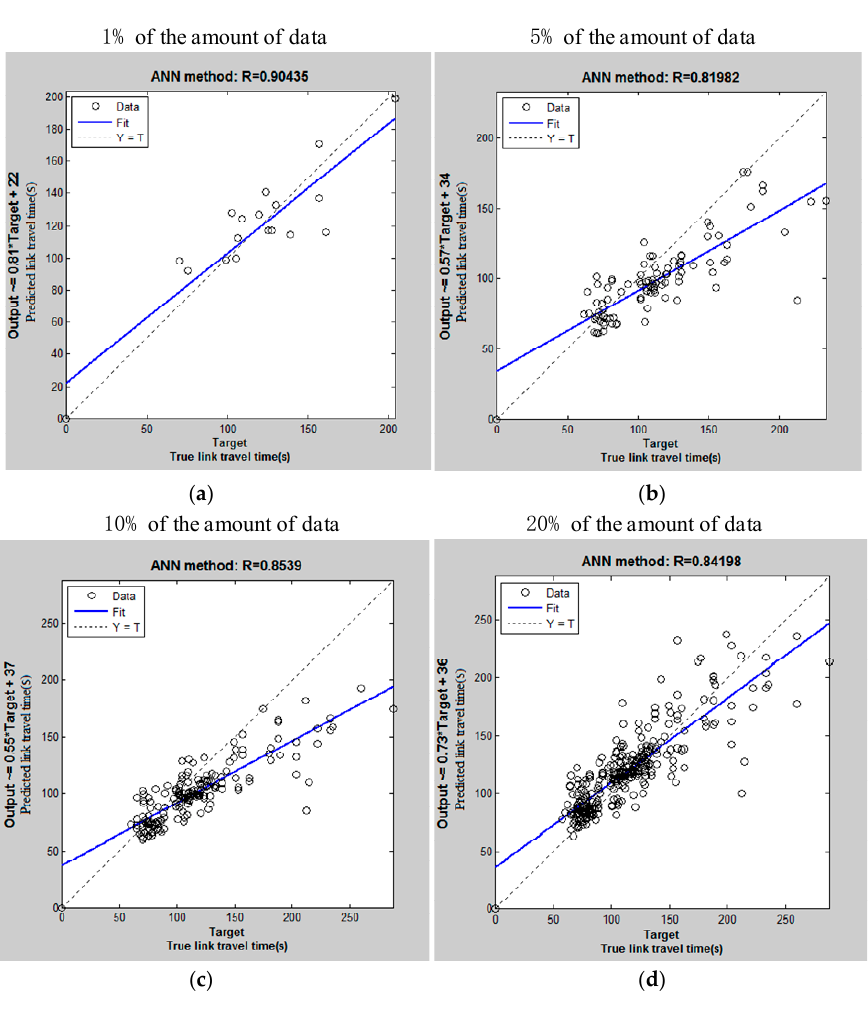
Figure 9. Correlation of link 82 between true link travel time and estimated link travel time.